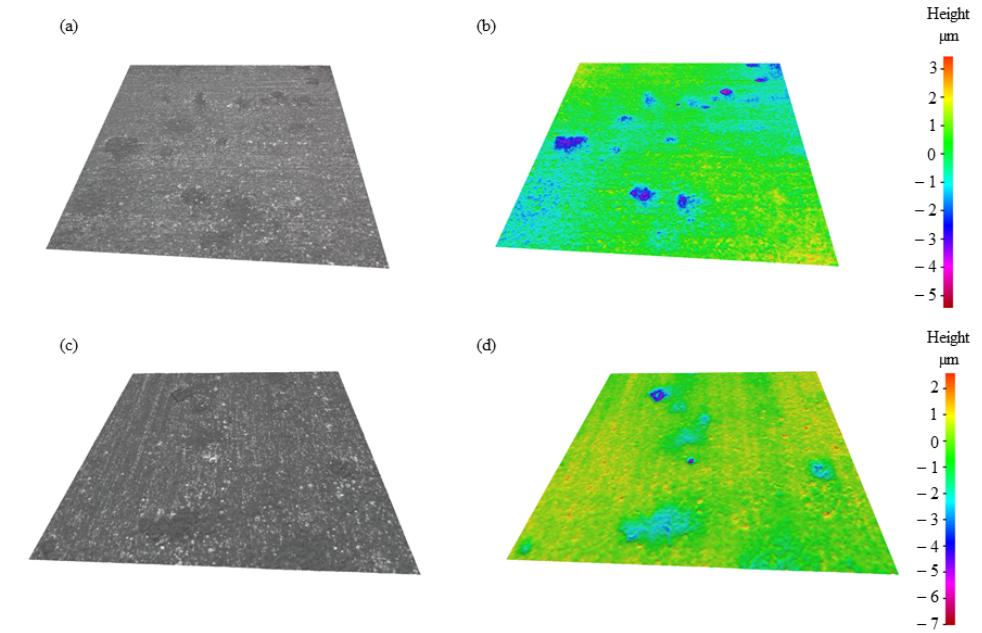
Figure 5. Infinite focus microscopy (IFM) images after CPP in deaerated 1.0 wt.% NaCl: ( a ) TMP TWIP sample, ( b ) TMP TWIP topography, ( c ) recrystallized TWIP, and ( d ) recrystallized TWIP topography.